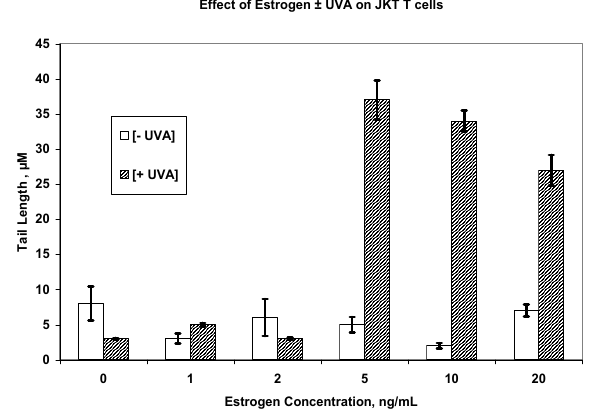
Figure 5: Comet assay of Jurkat T cells treated with estrogen ± UVA where Y-axis is the Tail Length (µm) and x-axis is the different concentrations of estrogen used in comparison with controls which had no estrogen.